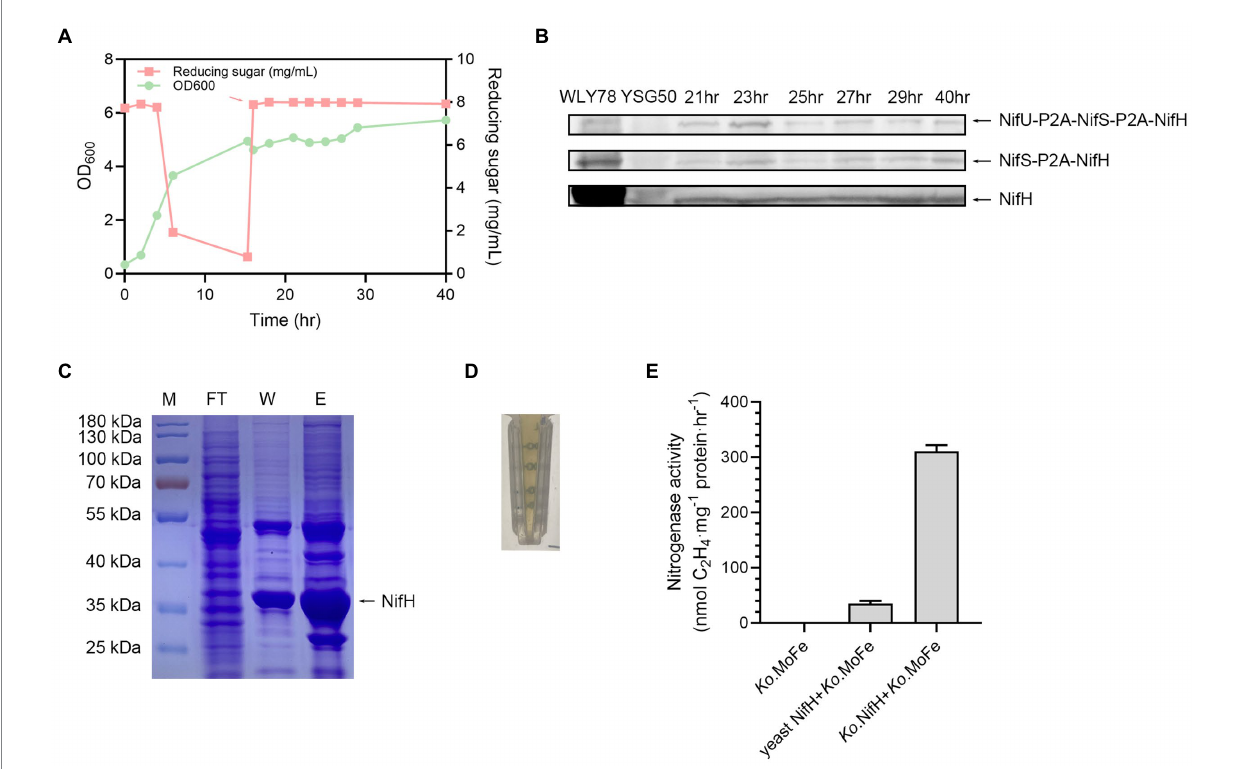
FIGURE 4 Growth of S . cerevisiae USHp and detection of expression and activity of NifH. (A) Batch fermentation process of S . cerevisiae USHp. OD 600 value (green) and concentration of deoxidize sugar (red) were continuously monitored during the process. The red arrow indicates addition time of 2% galactose and trace-metal solution. During the fermentation process, pH was automatically controlled at 5.8 by 5 M KOH, and temperature was controlled at 30 ° C. (B) Western blotting analysis of NifH expression with anti-NifH during the fermentation process. NifH was cleaved form, while NifS- P2A-NifH and NifU-P2A-NifS-P2A-NifH were fusion protiens. WLY78, P . polymyxa WLY78 as a positive control; YSG50, S . cerevisiae YSG50 as a negative control. (C) Purification of NifH proteins. Ni 2+ affinity column was used for the purification of the His-tagged NifH. M, molecular weight marker; FT, flow-through fractions; W, protein fractions eluted after washing with washing buffer; E, protein fractions eluted after washing with elution buffer. Arrow point to purified NifH protein. (D) The characteristic brown color of nitrogenase Fe protein. (E) Activity assays of yeast NifH protein. Fe protein activity was analyzed by assessing the nitrogenase activity (acetylene reduction activity) of the mixtures of NifH protein and the K . oxytoca MoFe protein ( Ko . MoFe). Ko . MoFe without K . oxytoca Fe protein ( Ko . Fe) as a negative control. Ko . Fe with addition of Ko . MoFe as a positive control. The error bars indicated SEM, n =